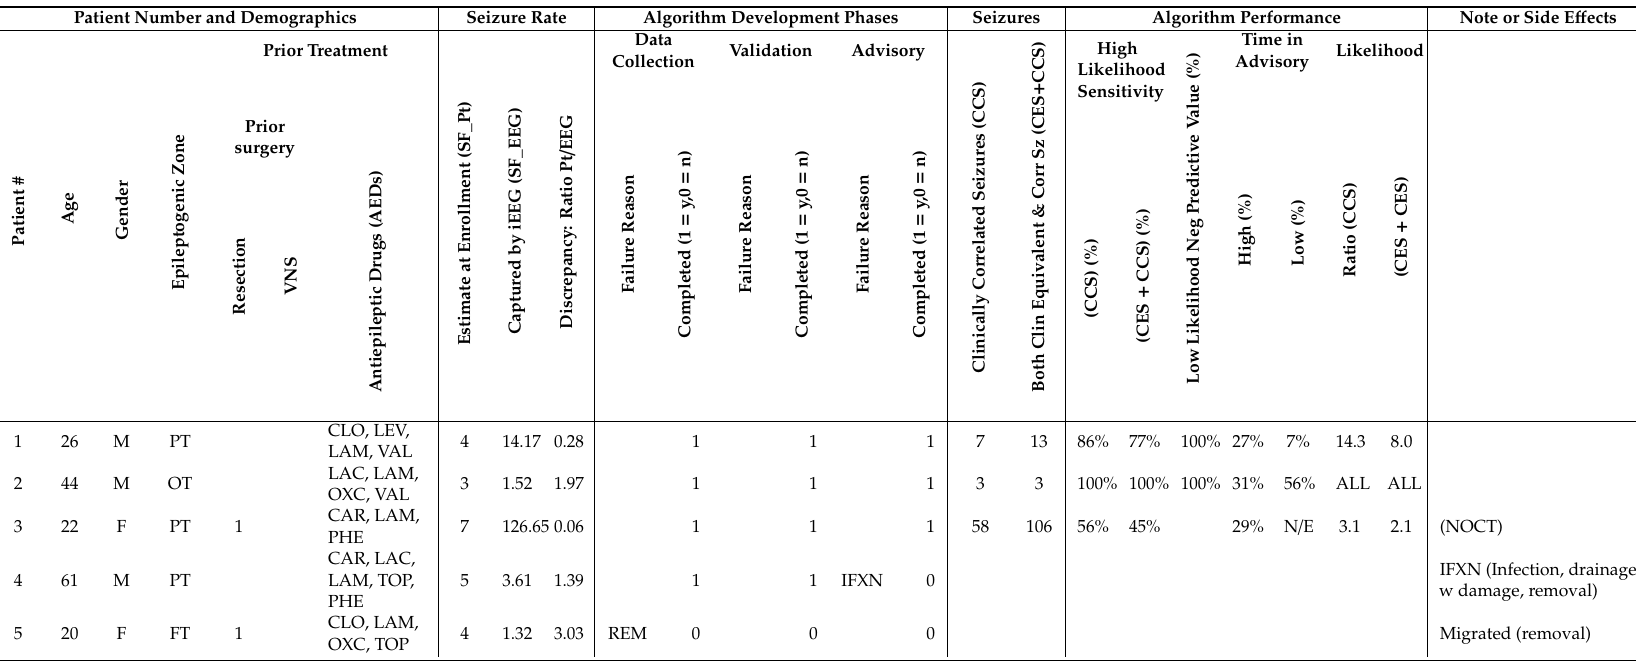
Table 1. Patient Demographics, Algorithm Development Phases, Algorithm Performance. See text for description. Data from clinical paper [17]. (KEY: AEDs: CAR = Carbamazepine, CLO = Clonazepam, LAC = Lacosamide, LEV = Levetiracetam, LAM = Lamotrigine, OXC = Oxcarbazepine, PER = Perampanel, PHE = Phenytoin, RET = Retigabine, TOP = Topiramate, VAL = Valproate, ZON = Zonisamide. Notes include: IFXN: Patient discontinued the study prior to completing the four month initial follow up in the Advisory Phase due to explantation related to infection. The infection was evacuated, but incidental damage to the lead required removal. REM: Device removal due to adverse event (migration with tethering of subcutaneous wire causing discomfort, prompting patient to request explantation) prevented completion of data collection phase. FAIL: Algorithm failed to meet Red Indicator (high likelihood) performance criteria required to progress to Advisory Phase, and the device was explanted. VNS: For the single patient with a VNS system, the VNS was explanted when the SAS was implanted. Likelihood ratio = ([number of events in high advisory] / [time in high advisory]) / ([number of events in moderate advisory] / [time in moderate advisory]). ALL: All events occurred during the high likelihood advisory (infinite ratio). (PLAN): Device failed to meet criteria for algorithm performance, but chronic monitoring facilitated subsequent identification & resection of a seizure focus. (PSYCH): Some seizures were found to be psychogenic. (NOCT): Monitoring with SAS revealed nocturnal seizures (10–20 / night), felt to be the cause of daytime drowsiness.) Patient Number and Demographics Seizure Rate Algorithm Development Phases Seizures Algorithm Performance Note or Side E ff ects Time in Data Likelihood Validation Advisory Collection Advisory G Prior EE